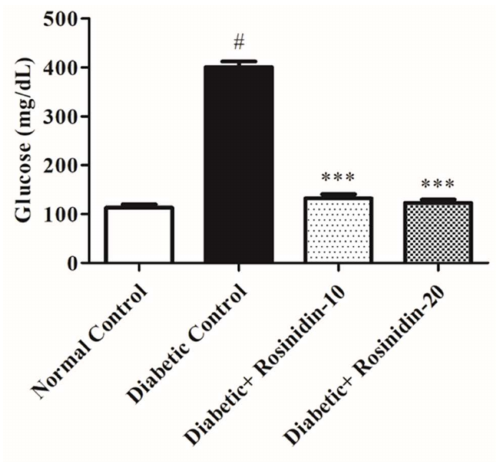
Figure 2. Effect of rosinidin on blood glucose against that of STZ-induced diabetic rats ( n = 6). Values are expressed as mean ± SEM. # p < 0.05, normal control vs. diabetic control; *** p < 0.001, diabetic control vs. rosinidin-10,